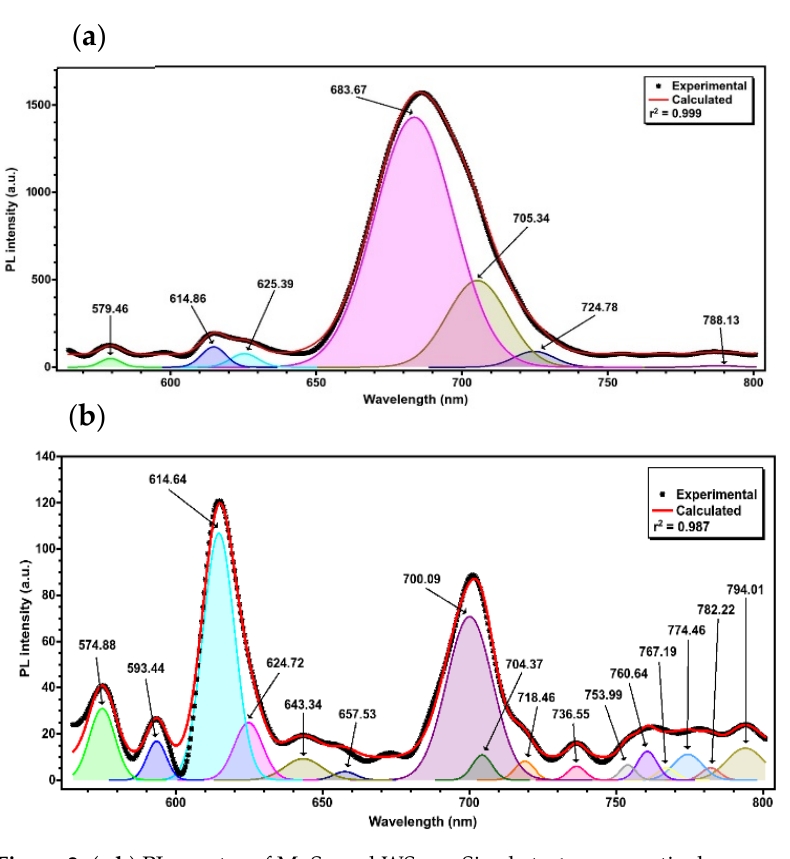
Figure 2. ( a , b ) PL spectra of MoS 2 and WS 2 on Si substrates, respectively.